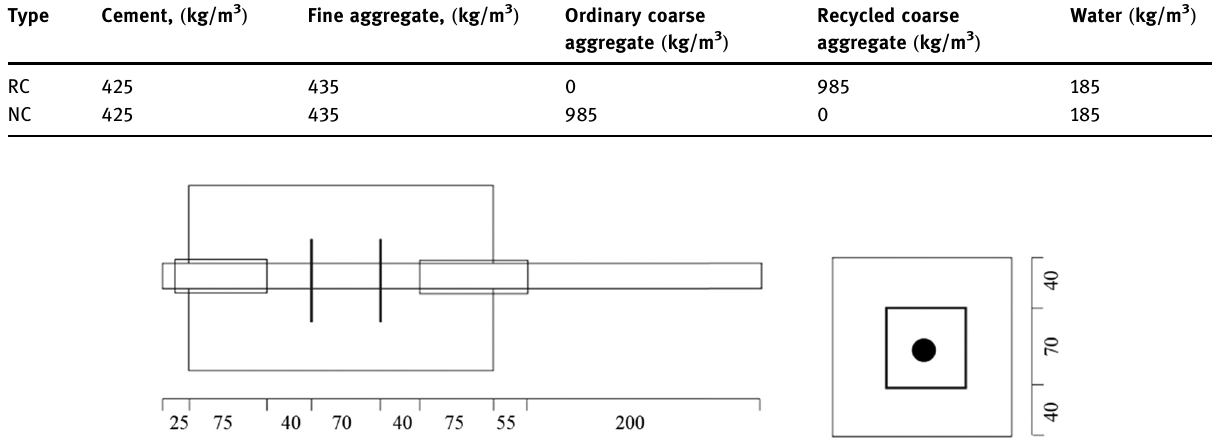
Figure 1: Size of specimens ( mm )